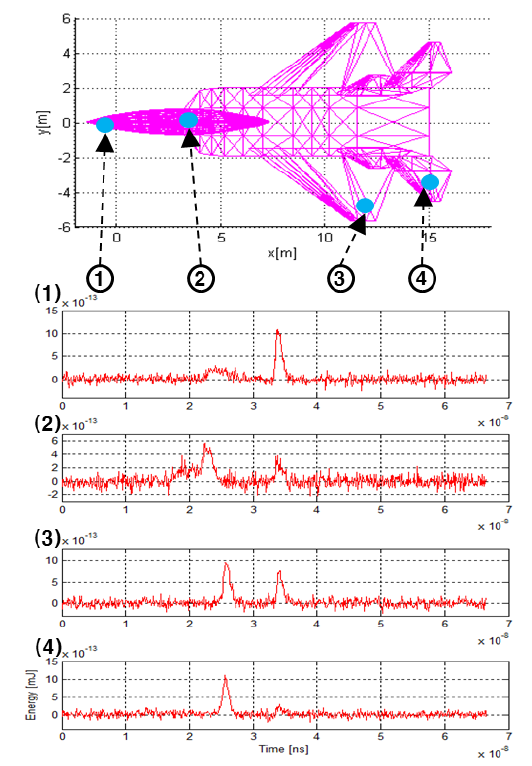
Figure 21. Waveform of several